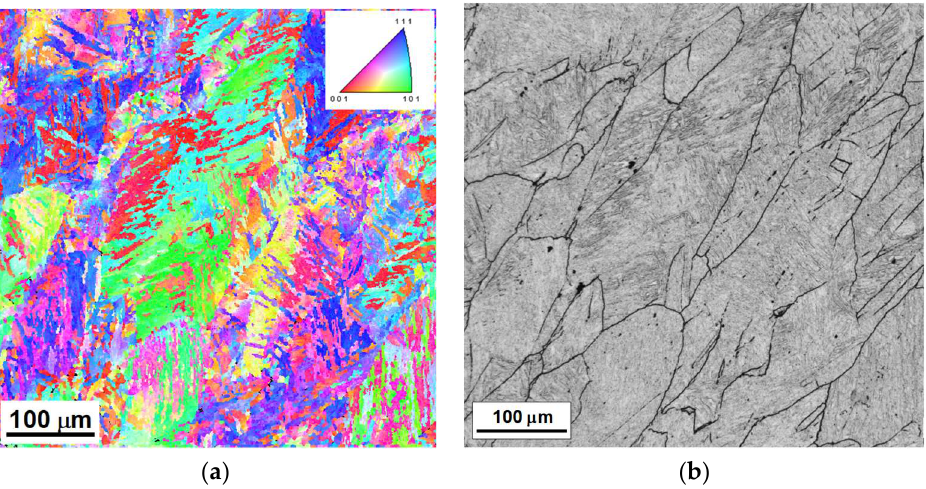
Figure 5 . ( a ) IPF (Inverse pole figure) ND map obtained from the martensitic sample quenched from deformed austenite; and ( b ) corresponding optical micrograph taken after Bechet-Beaujard etching from the martensitic sample (Step size = 1 μm, 500 × 500 μm 2 ).